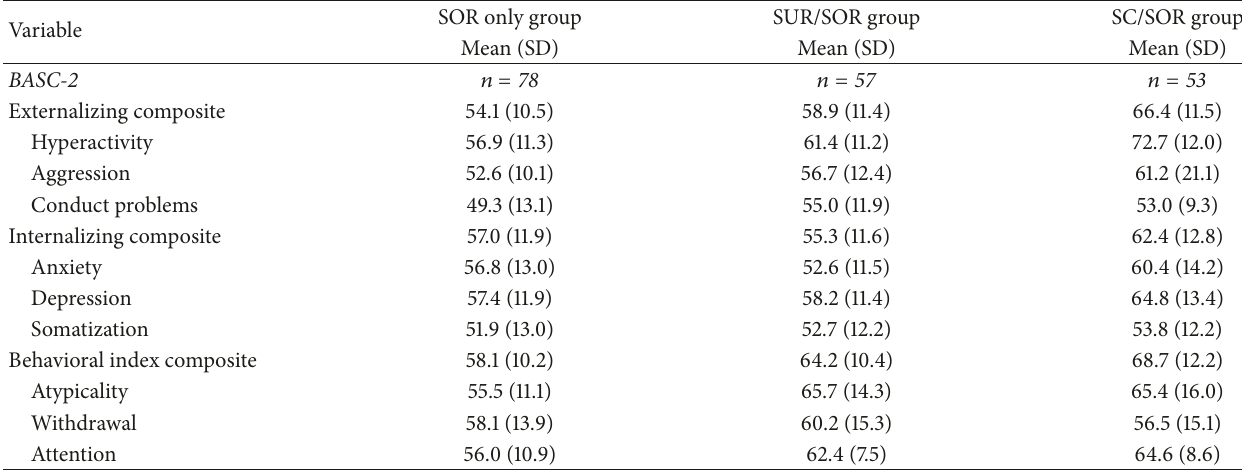
Table 3: Mean scores from BASC-2 by cluster